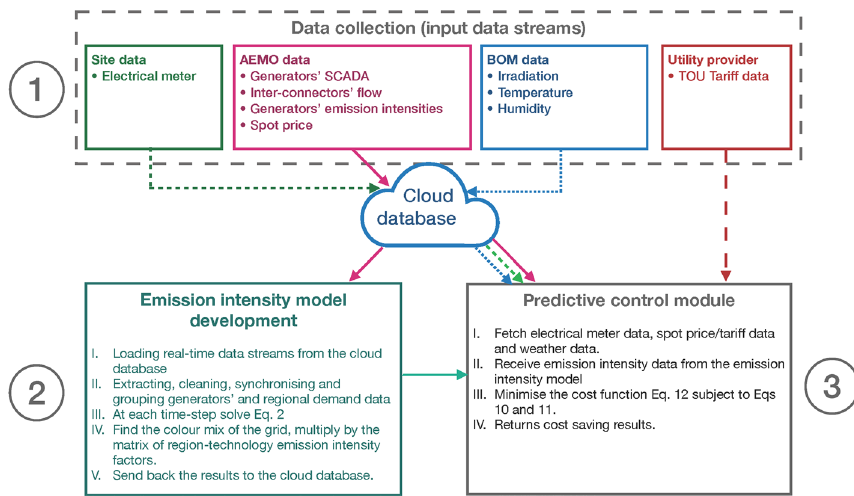
Fig. 1 Schematic of the analysis framework, (1) data collection, (2) consumption-based emission intensity model, (3) MPC module for obtaining the cost-saving and emissions reduction